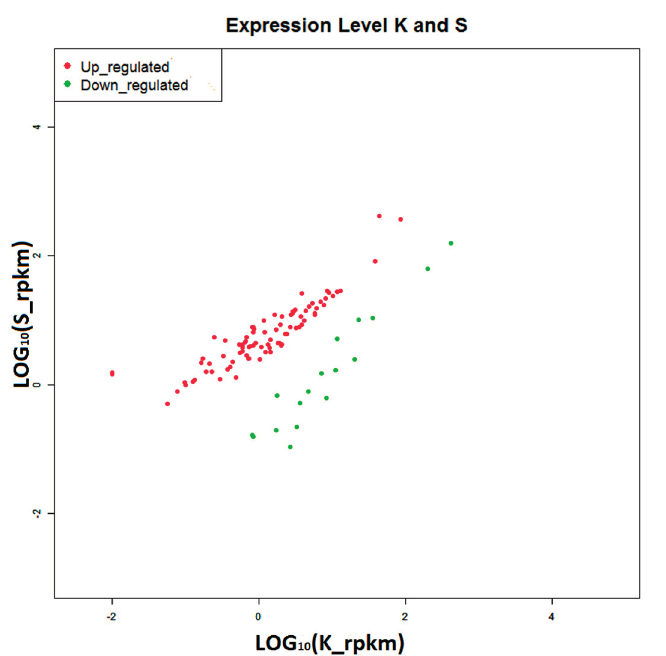
Figure 9. Differentially expressed genes from susceptibility group (S) comparing with control group (K). Red points represent 86 up-regulated genes, green point represents 16 down-regulated